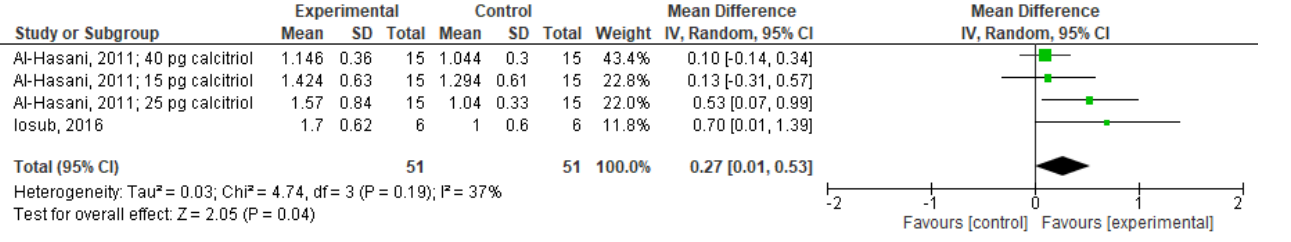
Figure 3. Results of meta-analysis (mean difference) and forest plot.